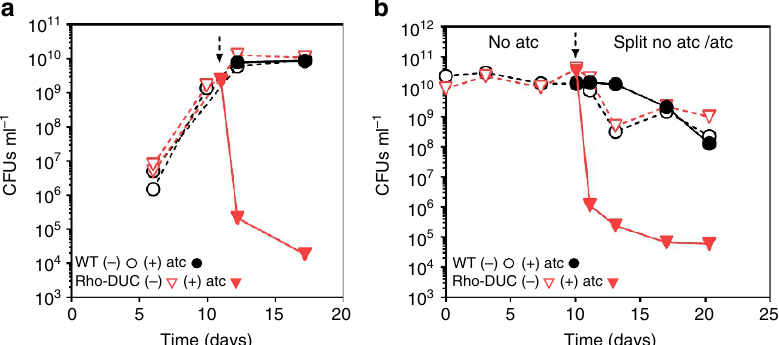
Figure 4 | Depleting Rho kills replicating and non-replicating M. tuberculosis . Impact of Rho deletion by addition of atc on the viability of WTand Rho- DUC M. tuberculosis strains during growth in liquid media ( a ) and starvation in PBS ( b ). The dotted arrows indicate when atc was added. In ( a ) data are means of representative duplicate (WT) or triplicates (Rho-DUC) cultures of an experiment that was performed five times ( ± s.d., some error bars are too small to be seen). The experiment in ( b ) is representative of four